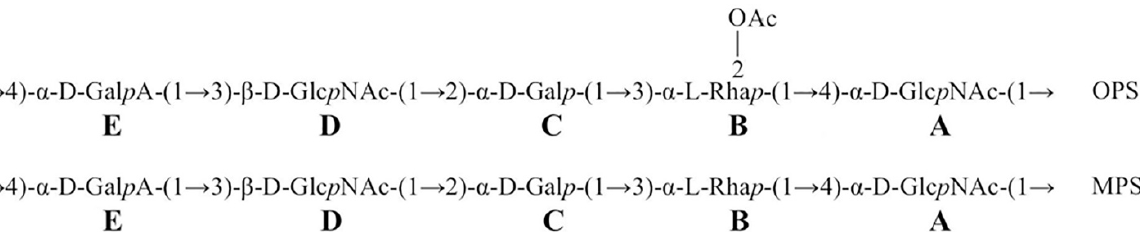
Figure 6. Structures of the O-specific polysaccharide (OPS) and modified (O-deacetylated) polysac- charide (MPS) from P. versatile F131.